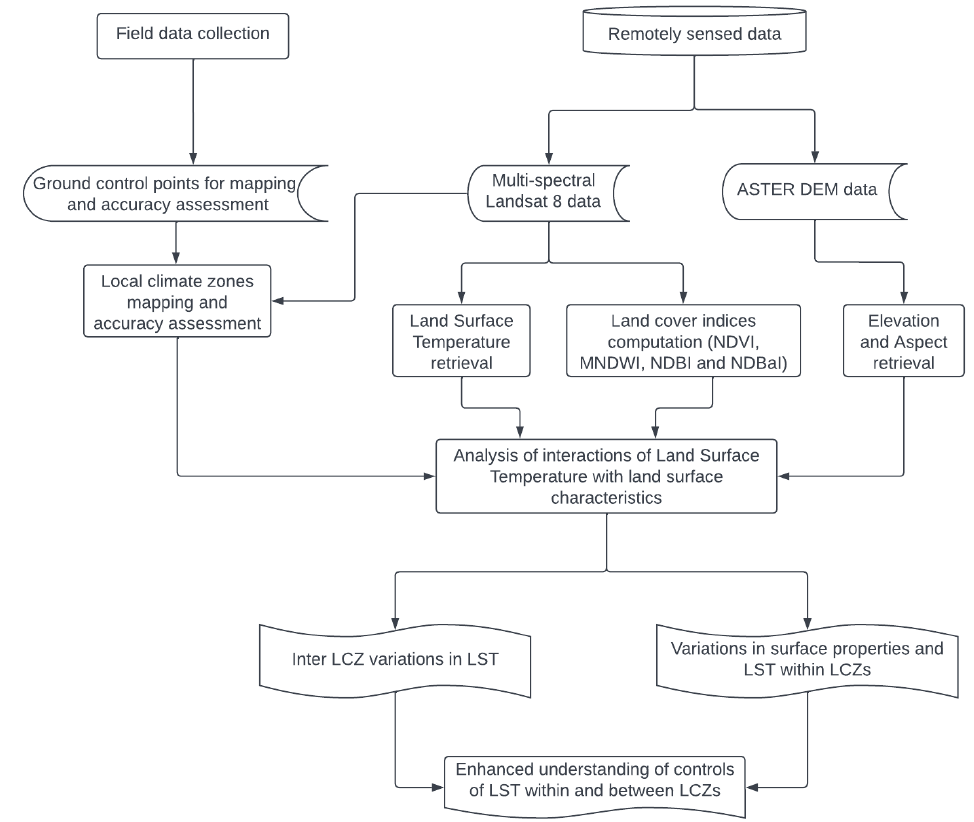
Figure 2. Flowchart summarizing the approach used in this